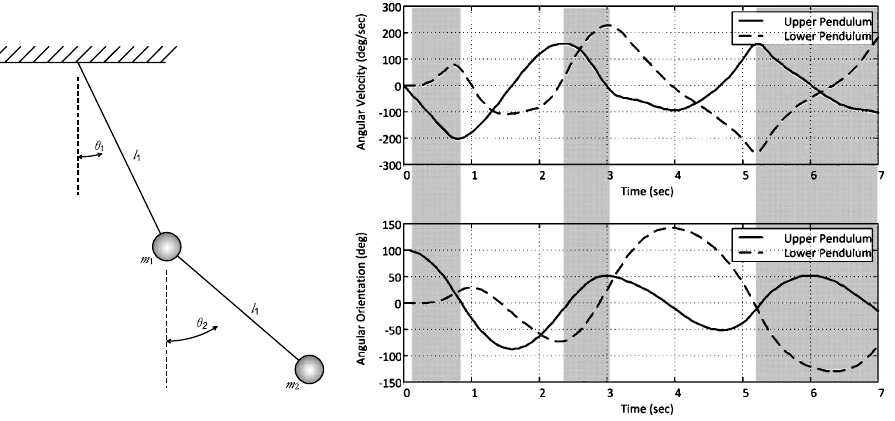
Fig. 2. Angular velocity (upper graph) and angular orientation (lower graph) of the pendula of a typical double pendulum highlighting the periods (shaded area) when the upper pendulum angular velocity is decreasing and is associated with increased angular velocity in the lower pendulum.